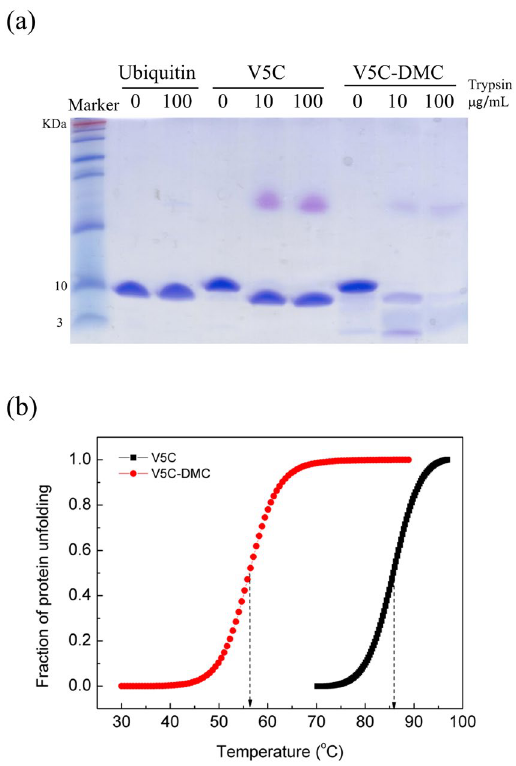
Figure 4. Comparison of structural stability of V5C and V5C-DMC. V5C and V5C-DMC were dissolved in DI (pH 5.7) to a final concentration of ~20 μ M. ( a ) Wild-type ubiquitin, V5C, and V5C-DMC were digested by different concentrations of trypsin and analyzed by SDS-PAGE. ( b ) The thermal denaturation curves of V5C and